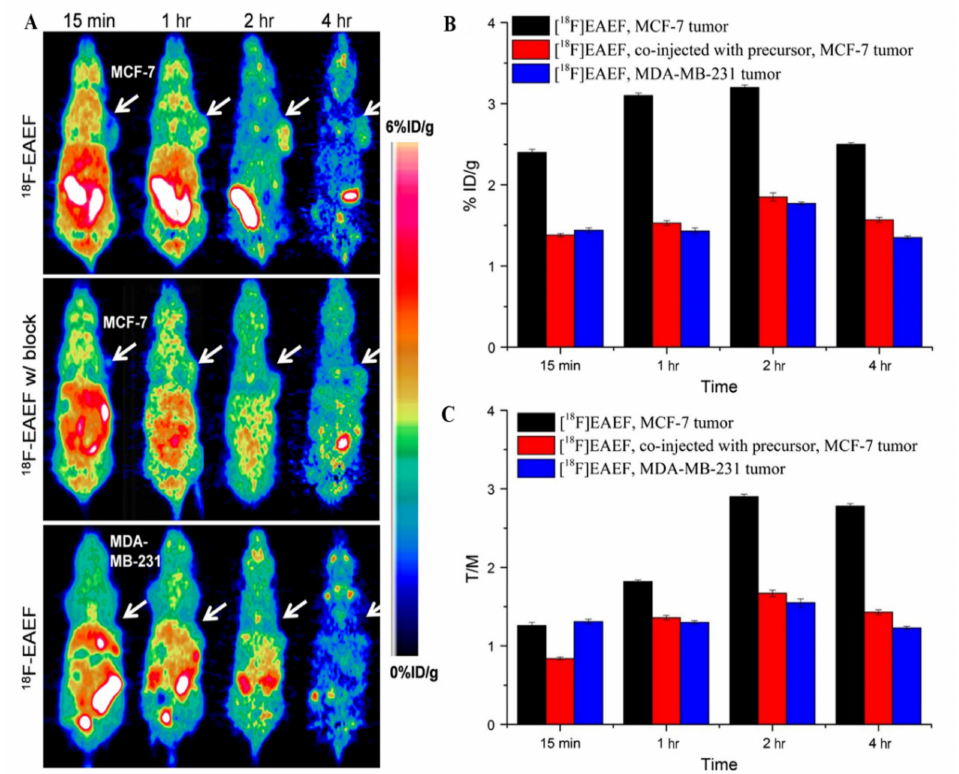
Figure 6. Chemical structure of PET imaging and tumor uptakes in PR-positive MCF-7 and PR- negative MDA-MB-231 tumor-bearing mice at different times after injection of 18 F-EAEF. ( A ) micro- PET images of MCF-7 tumor with 18 F-EAEF (up), co-injected excessive precursor (middle), and MDA-MB-231 tumor with 18 F-EAEF (bottom); ( B ) tumor uptakes and ( C ) tumor-to-muscle ratios at 15 min, 1 h, 2 h, and 4 h post-injection according to PET imaging